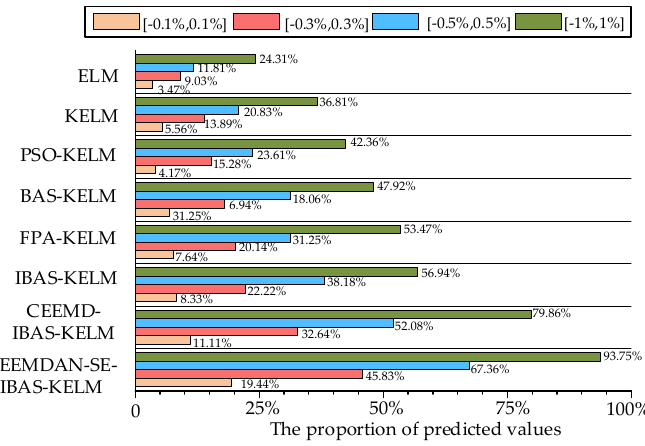
Figure 9. Statistical diagram of error interval of each prediction model.